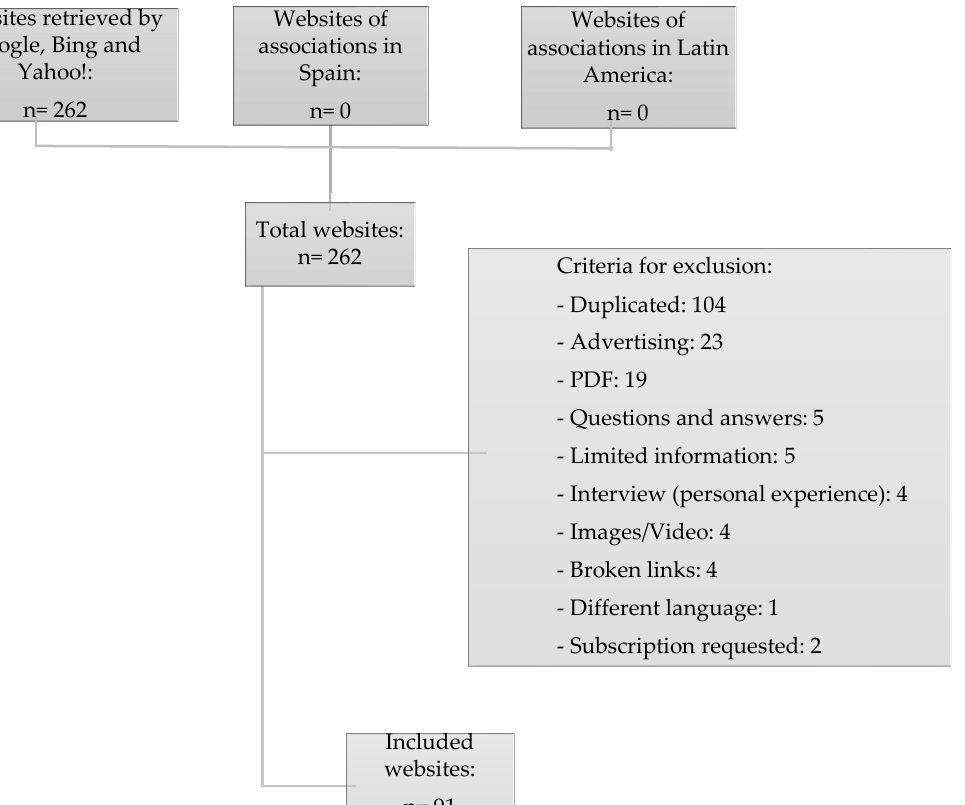
Figure 1. Selection process of websites.